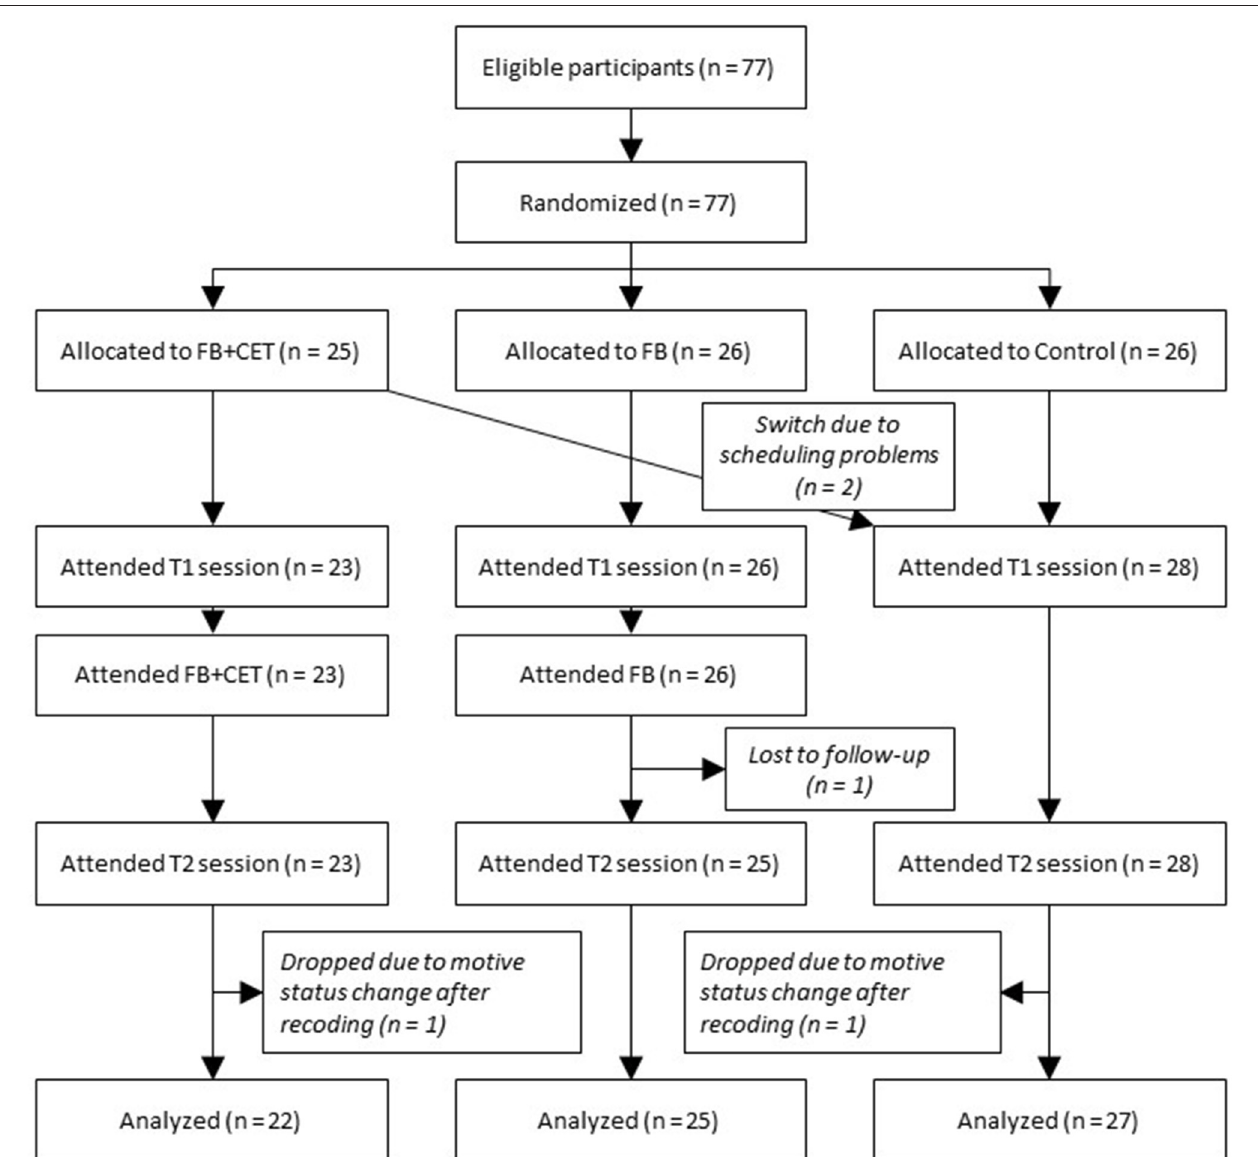
FIGURE 1 | Consolidated Standards of Reporting Trials (CONSORT) diagram illustrating flow of participants through the study. FB, motivational feedback; FB + CET, motivational feedback plus congruence-enhancement training.